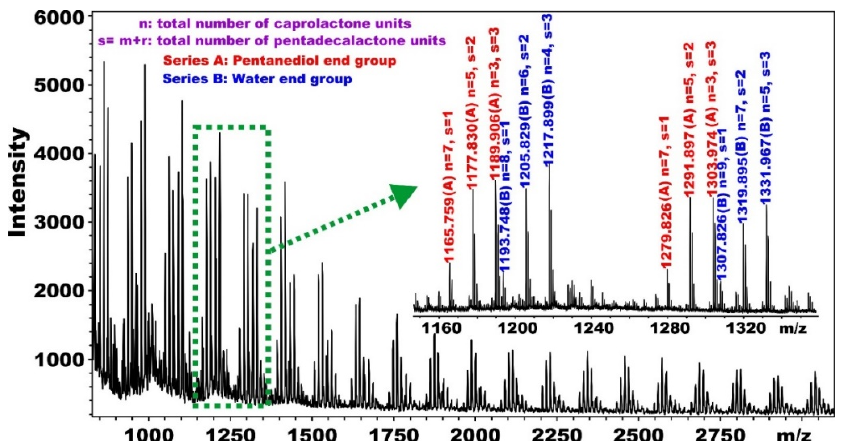
Figure 2. MALDI-TOF MS spectrum of sample PPDL-3. The numbers in the brackets represent the numbers of the caprolactone and pentadecalactone repeat units. The isotopic distribution, measured and calculated (green in brackets) m / z values are shown in the inset (top right corner).